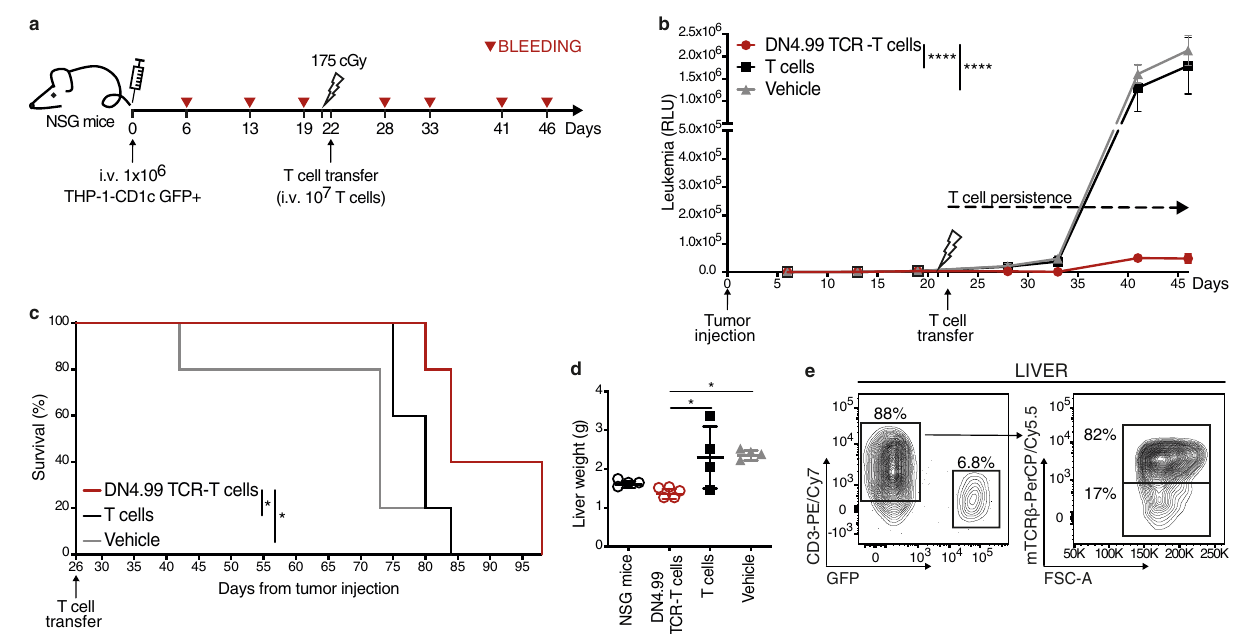
Fig. 7 In vivo anti-leukemia ef fi cacy of DN4.99 TCR-T cells against THP-1-CD1c-tumor cells. DN4.99 TCR-transduced T (DN4.99 TCR-T) cells and non- transduced T cells (T cells), all at 70% CD8 + /30% CD4 + , were assessed for the ability to control the progression of THP-1-CD1c acute leukemia in vivo. a NOD.Cg-Prkdcscid IL- 2rgtm1Wjl/SzJ (NSG) mice ( n = 15) received intravenous (i.v.) injection of 10 6 THP-1-CD1c cells co-expressing secreted LUCIA luciferase. Three weeks later the mice were sub-lethally irradiated, followed 24 h later by the transfer of 10 7 DN4.99 TCR-T cells (red lines/dots), T cells (black lines/squares), or vehicle (gray line/triangles). n = 5 mice/group. b Tumor progression was monitored weekly in blood collections by bioluminescence assay and depicted as the Relative Light Unit (RLU) detected at each time point. Data are represented as mean ± SEM. **** P < 0.0001 determined on AUC by Ordinary one-way ANOVA followed by Tukey ’ s multiple comparison test. c Kaplan – Meier survival curves show a signi fi cant increase in the survival of mice receiving DN4.99 TCR-T cells compared to the control groups. * P = 0.0368 with T cells; * P = 0.0274 with vehicle determined by log-rank (Mantel – Cox) test. d Reduced endpoint liver weight in mice receiving DN4.99 TCR-T cells (red dots) compared to the control groups (non-injected aged-match NSG mice: white dots; mice receiving: T cells, black squares; vehicle, gray triangles), determined at sacri fi ce (day + 46). Data are represented as mean ± SD. * P = 0.01557 with T cells; * P = 0.0224 vehicle determined by Ordinary one-way ANOVA followed by Tukey ’ s multiple comparison test. e Persistenc e of DN4.99 TCR-T cells in the liver of mice, determined by fl ow cytometry at sacri fi ce. DN4.99 TCR-T cells and THP1-CD1c leukemia cells were identi fi ed by mouse (m)TCR β , human CD3, and GFP expression, respectively, among gated mouse CD45 - mononuclear hepatic cells. Results are representative of 5 independent experiments with independent T cell lines giving comparable